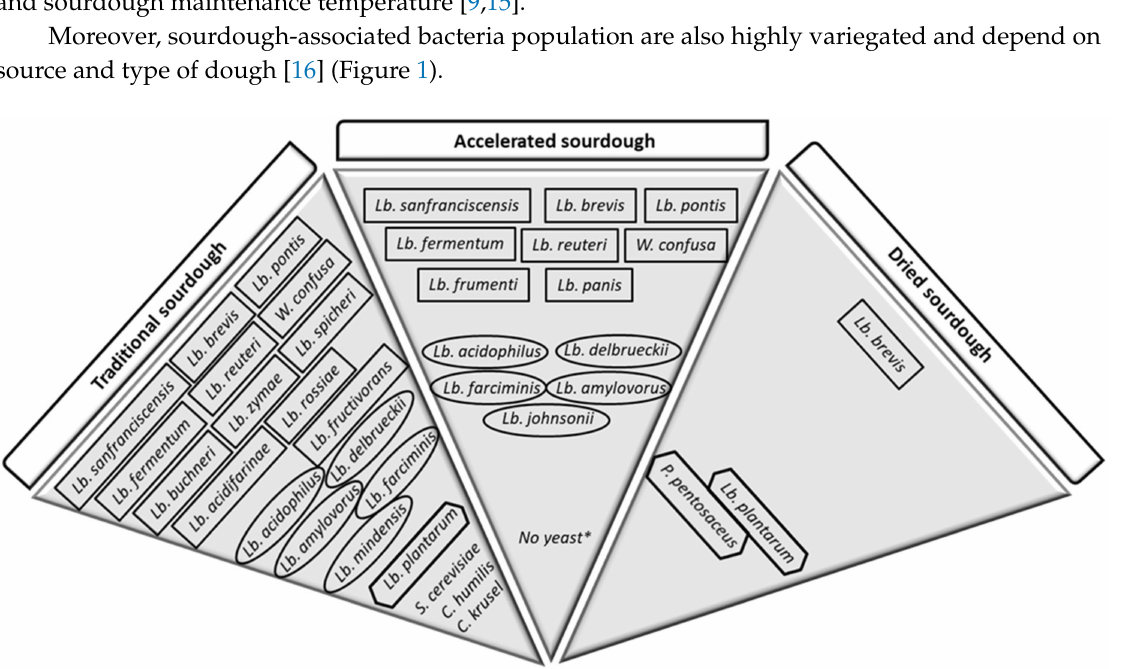
Figure 1. Principal microflora of three main types of sourdough (traditional, accelerated, and dried). Quadrangular shape = obligate hetero-fermentative strains; oval shape = obligate homo-fermentative strains; hexagonal shape = facultative hetero-fermentative strains; Lb. = Lactobacillus ; P. = Pediococcus ; W. = Weissella ; S. = Saccharomyces ; C. = Candida . * S. cerevisiae may be